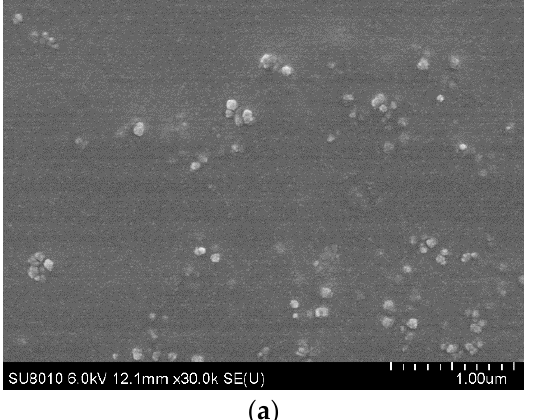
Figure 2. SEM images of CS nanospheres loaded with rTgPSA1 protein, showing nanosphere morphology, with bar representing ( a ) 1000 nm and ( b ) 500 nm.